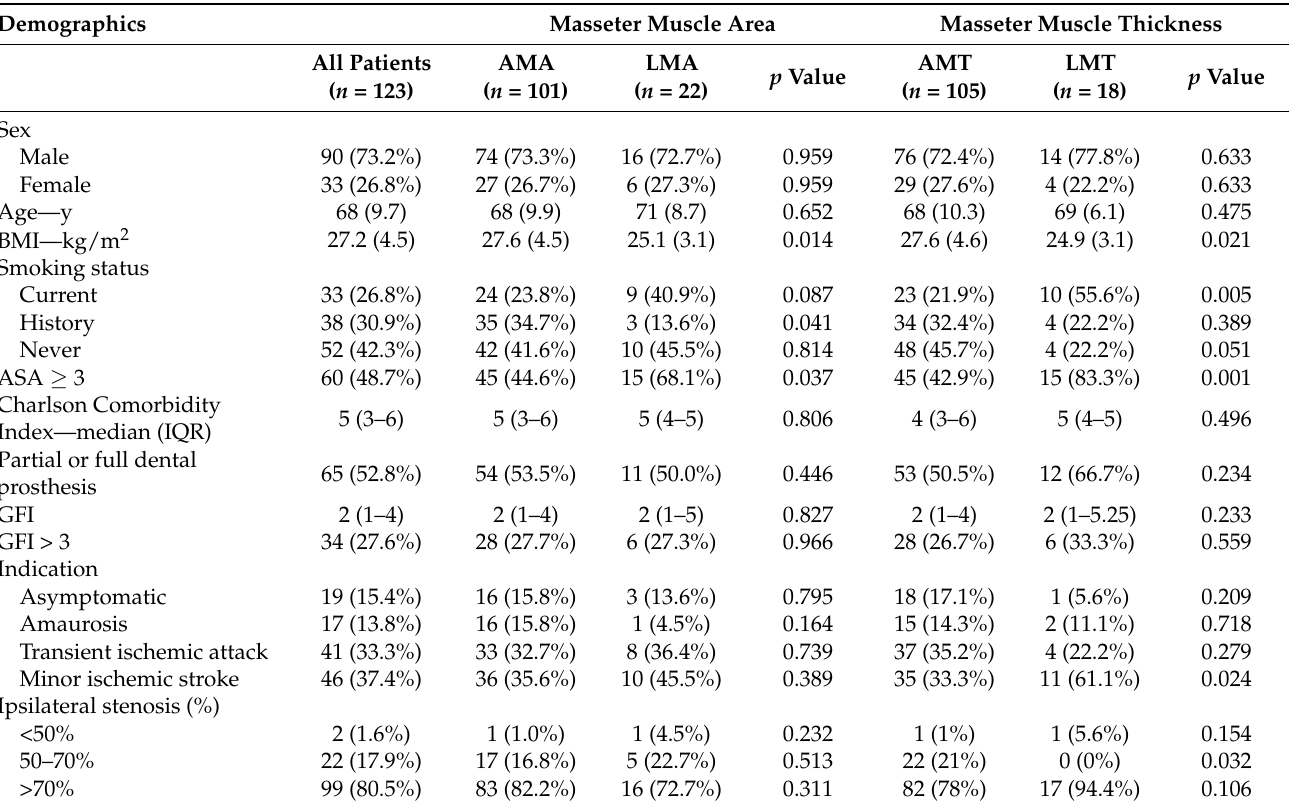
Table 1. Comparison of clinical characteristics by presence of adequate or low masseter muscle area and adequate or low masseter muscle